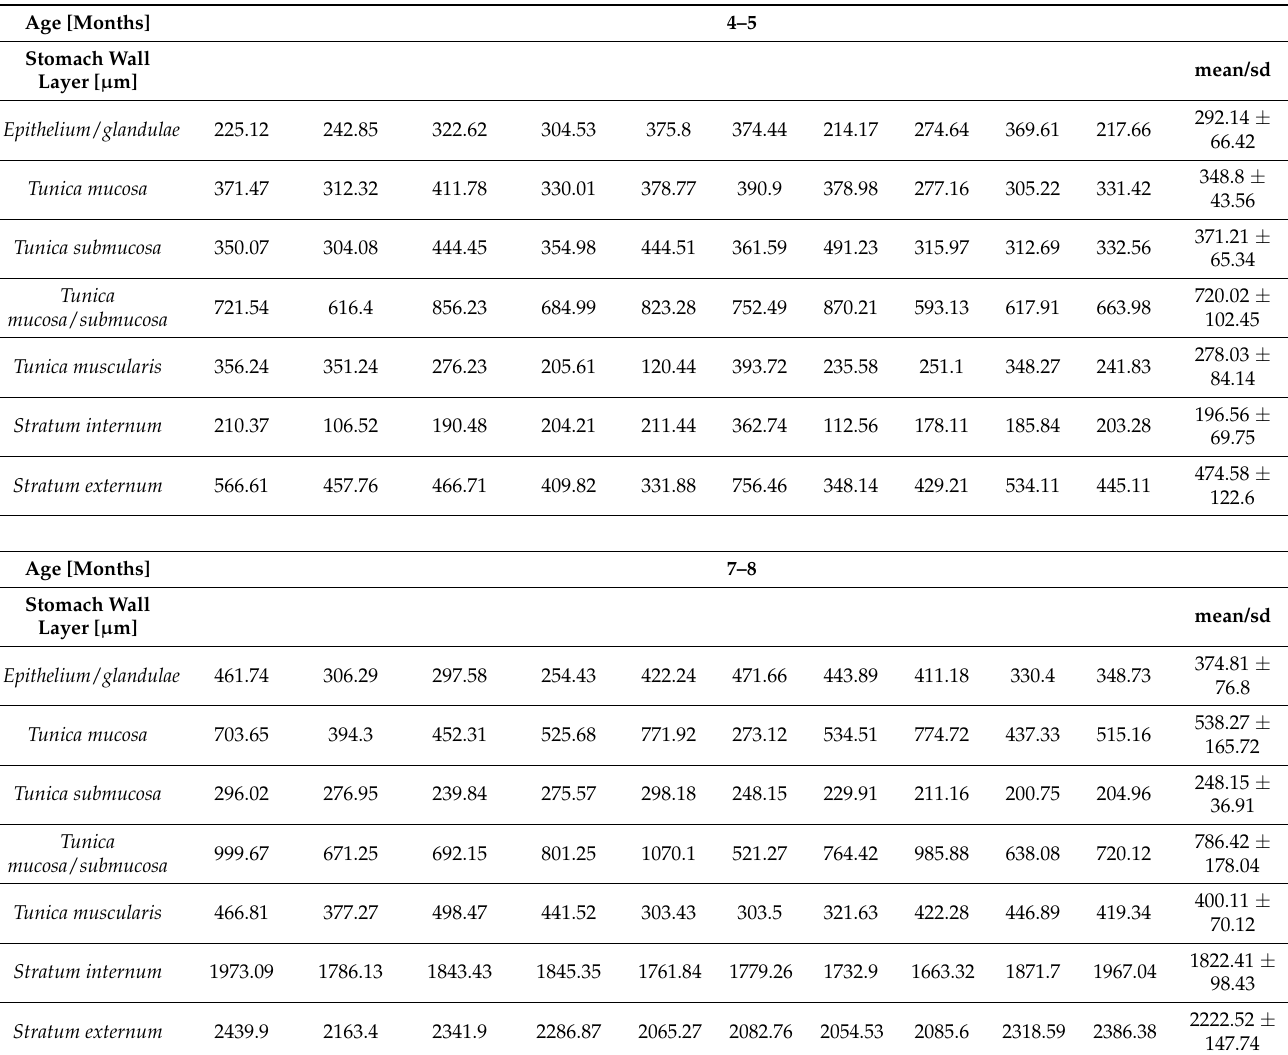
Table 3. Histometry of equine stomach—the plicated edge margin ( margo plicatus